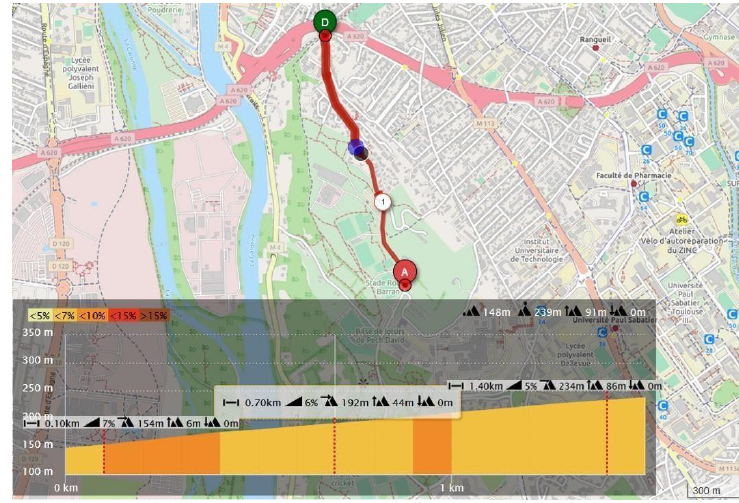
Figure 8. Outdoor test: Pech David route: 1.5 km with a 6% mean gradient.